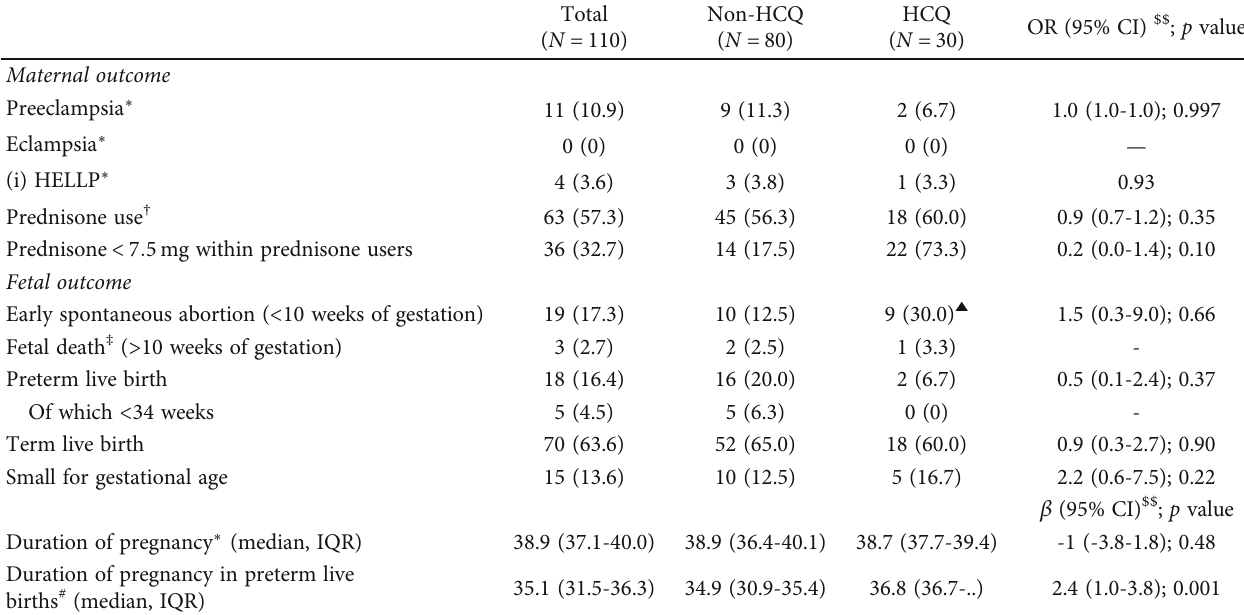
Table 2: Maternal and fetal pregnancy outcome according to HCQ